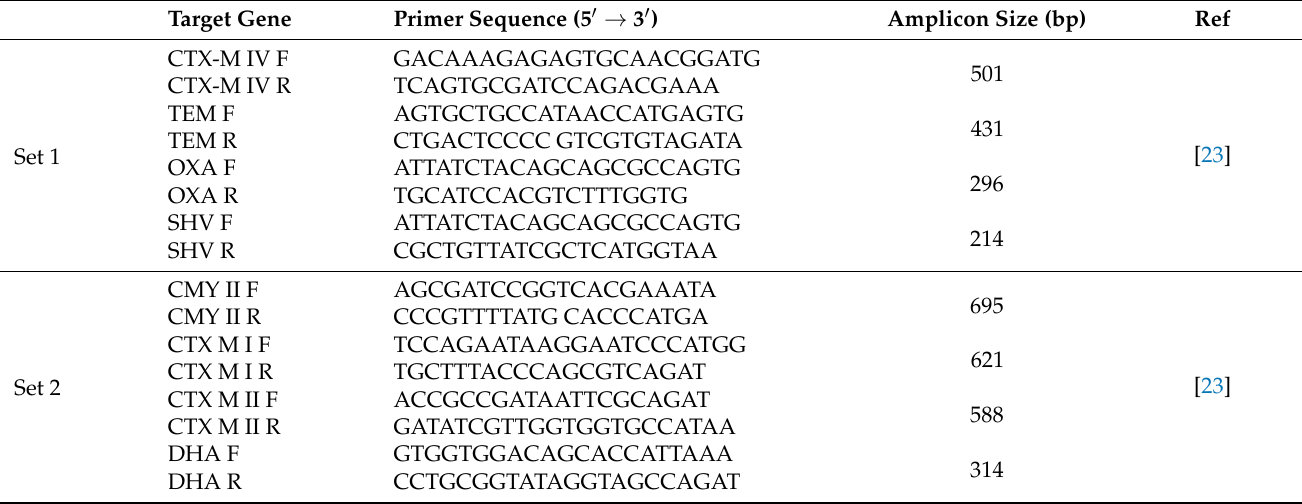
Table 1. Target gene, sequence, and amplicon size of forward and reverse primers used for the